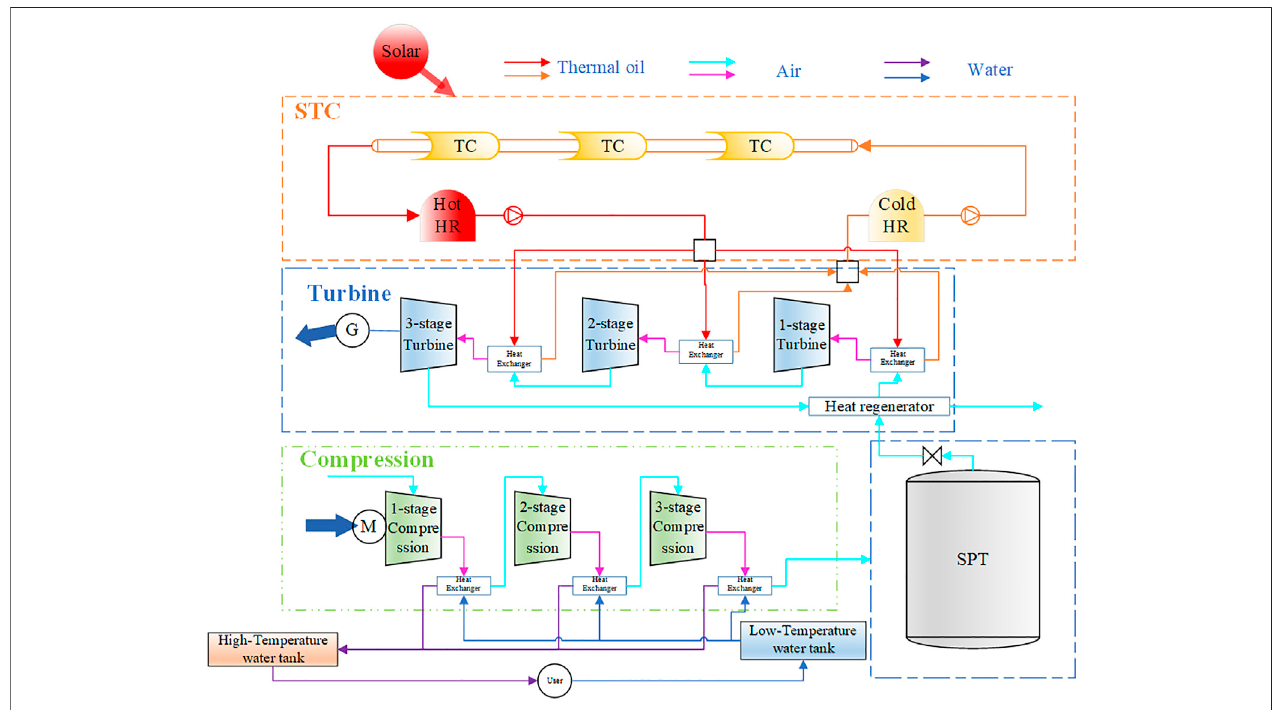
FIGURE 2 | The design scheme of HA-CAES.